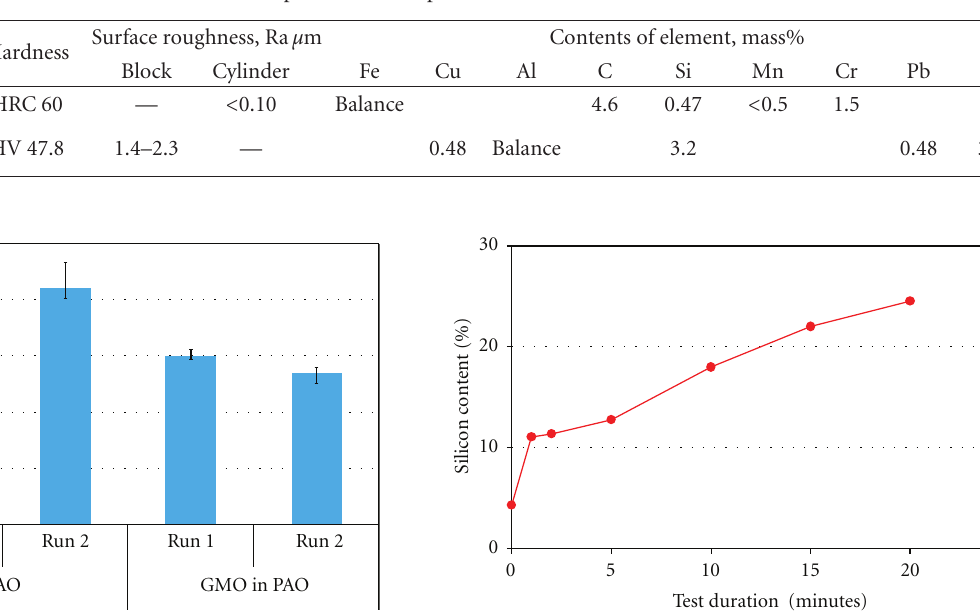
Table 2: Properties and composition of tribo-material.